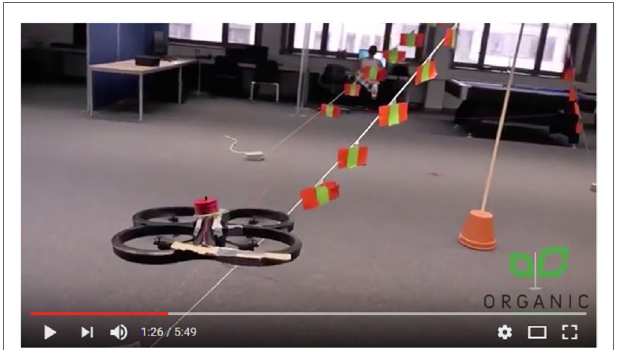
FigUre 3 | illustration of a spider drone at work (screenshot from a video): the ar.Drone Parrot 2.0 weaves a net surrounding the triangle installed in our lab . The corresponding video is available at https://www. youtube.com/watch?v = Lt8Von2kFK8 (last access: 13/09/2016).